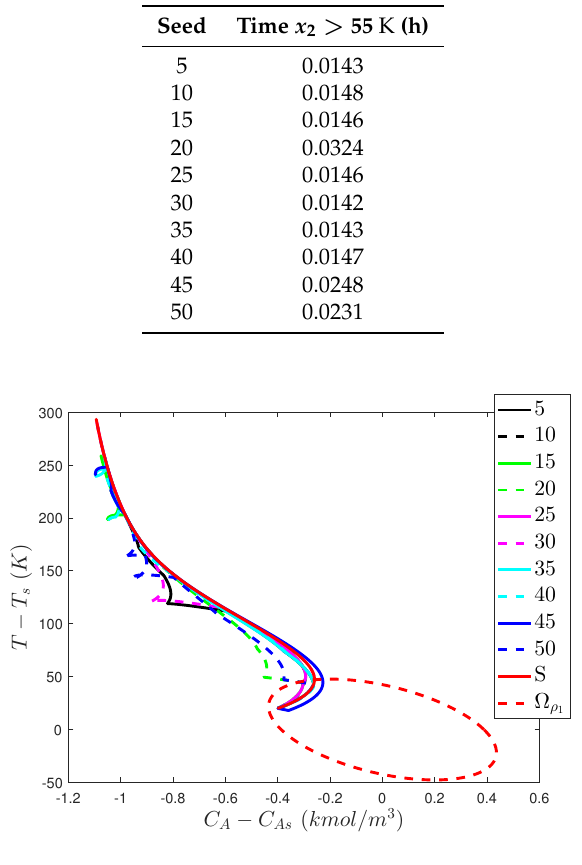
Figure 11. State-space trajectories for all of the situations in Table 4. The numbers in the caption represent the seed values for rng. ‘S’ represents the single